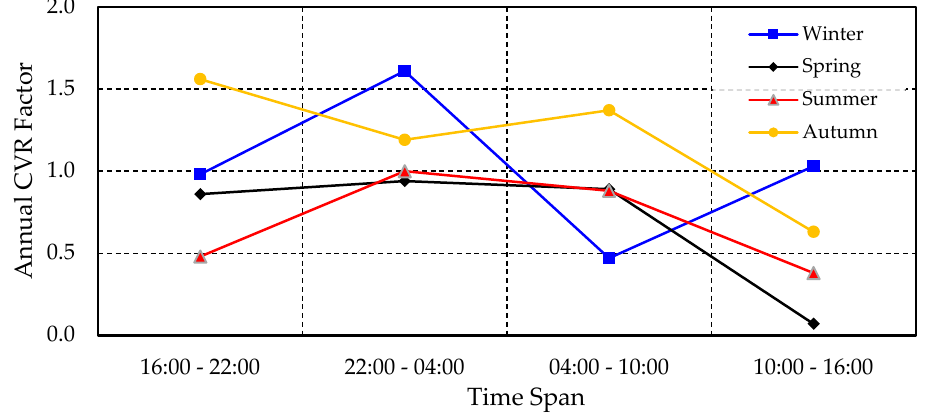
Figure 6. Annual CVR factors for active power.